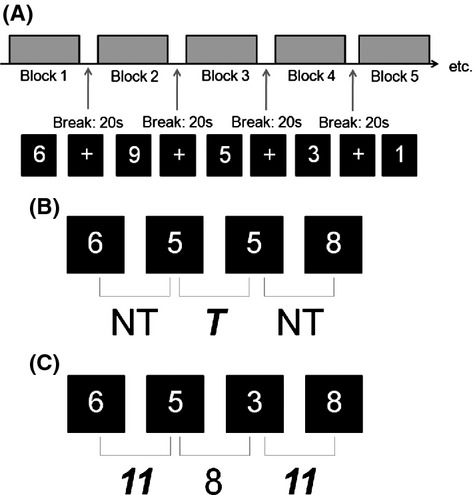
Illustration of (A) Study Design, (B) n-Back task and (C) PVSAT task. (A) illustrates the block design of the fMRI tasks (white numbers on black background) interspersed with rest screens (white cross on black background). Each block is preceded by an information screen telling the participant what type of block is coming next. At the end of the block, feedback (percent correct) is given, and the participant signals their wish to proceed to the next block by pressing any button. The example n-Back (B) is a 1-Back. First the number 6 appears, then 3 sec later the number 5, then 5 then 8. The task for 1-Back is to match the number currently presented to the number one previous. Five and 6 do not match, so the participant must respond using the nontarget button. However, 5 and 5 do match, so this requires a target button response. In the PVSAT example (C), the target number is 11 and the speed is 2s. First the number 6 appears, and then the number 5 appears 2 sec later, then 3, then 8. The task is to add the number on screen to the one previous: 5 + 6 = 11. This is the target number, so the participant must respond using the target button. Next, when the 3 appears, you must add it to the 5 (3 + 5 = 8). This is not the target number, so requires a nontarget button response.